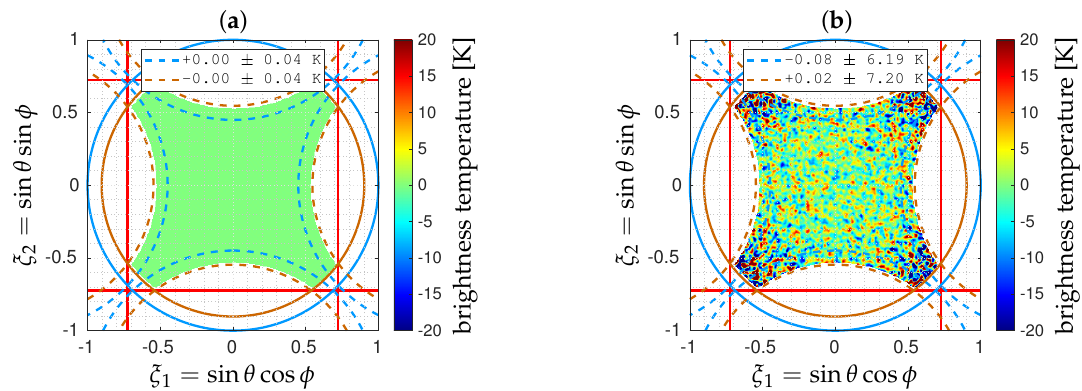
Figure 15. Error maps (cid:101) T n − T obtained in X polarization with the cross-shaped array shown in Figure 4 with the shortest spacing d set to 0.69 λ when ( a ) complex visibilities V are free from any additional random noise ∆ V and when ( b ) complex visibilities V are blurred by an additive Gaussian noise ∆ V with standard deviation set to 0.1 K (similar results are obtained in Y polarization). In both cases, the singular vectors V (cid:96) of (cid:101) G corresponding to the 16 smallest singular values σ (cid:96) have been discarded prior to the inversion. These maps have to be compared to those in Figures 8a and 9a where these singular vectors were taken into account in the computation of (cid:101) G + .